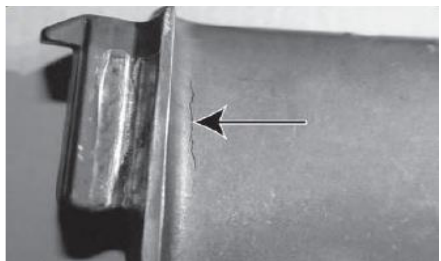
Figure 11. Fatigue crack of blade.